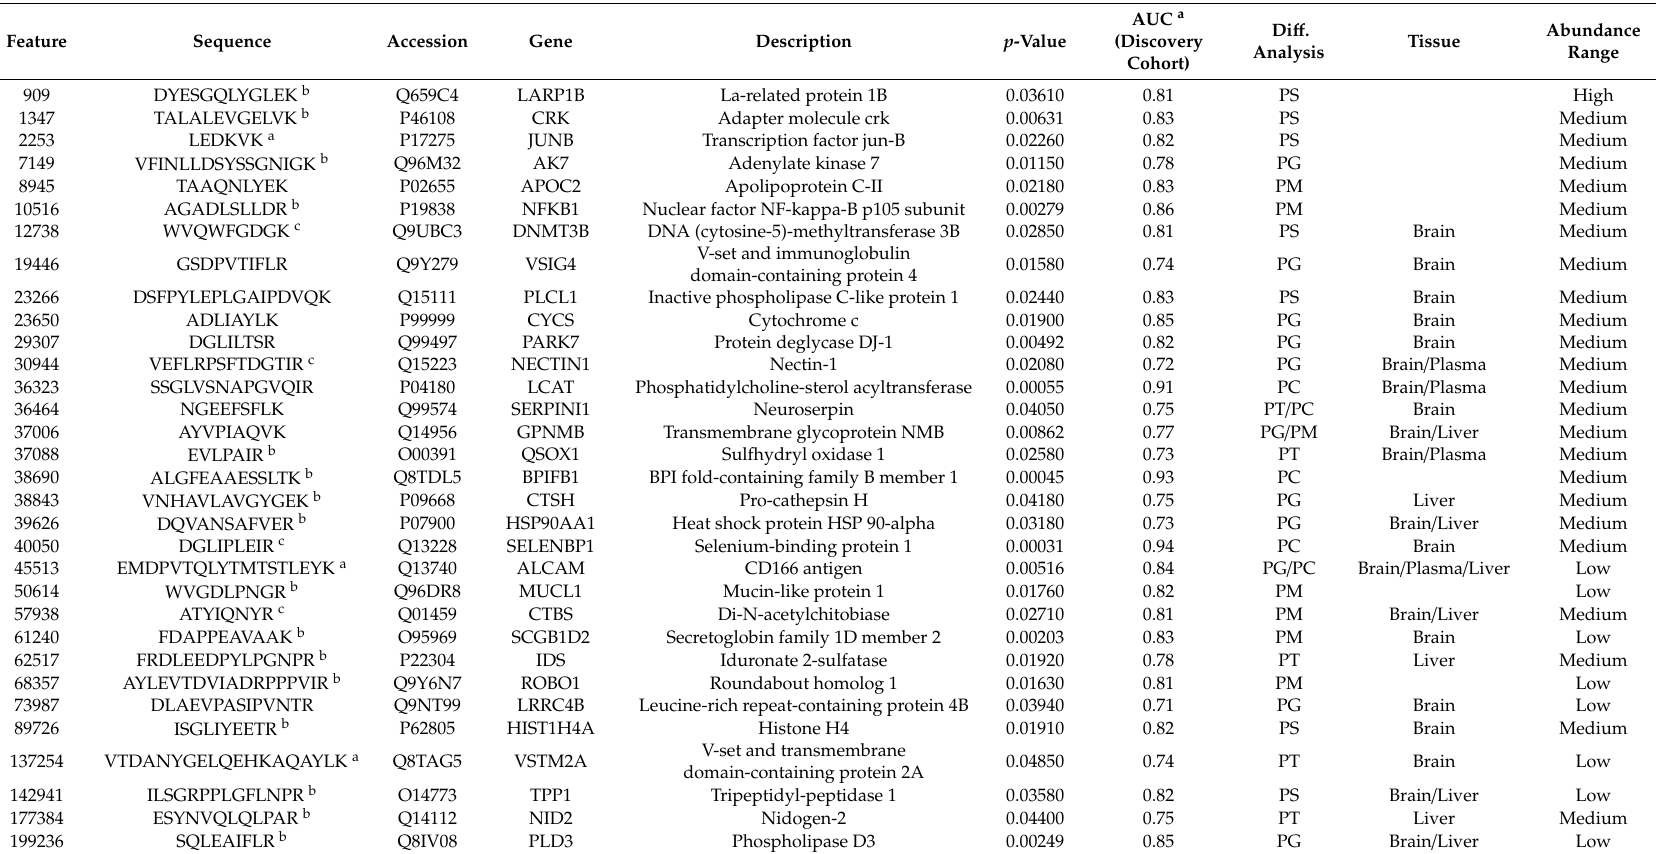
Table 4. Candidate peptide biomarkers selected for the development of selected reaction monitoring (SRM) assay. PS, PCNSL vs. SCNSL; PG, PCNSL vs. glioma; PD, PCNSL vs. disease; PM, PCNSL vs. MS; PT, PCNSL vs. other tumors; PC, PCNSL vs. tumor-free control. Score: MS Amanda score (quality of identification). p -value: t-test between the compared groups. AUC: area under the curve calculated between the compared groups. Tissue database: UniProt tissue annotation